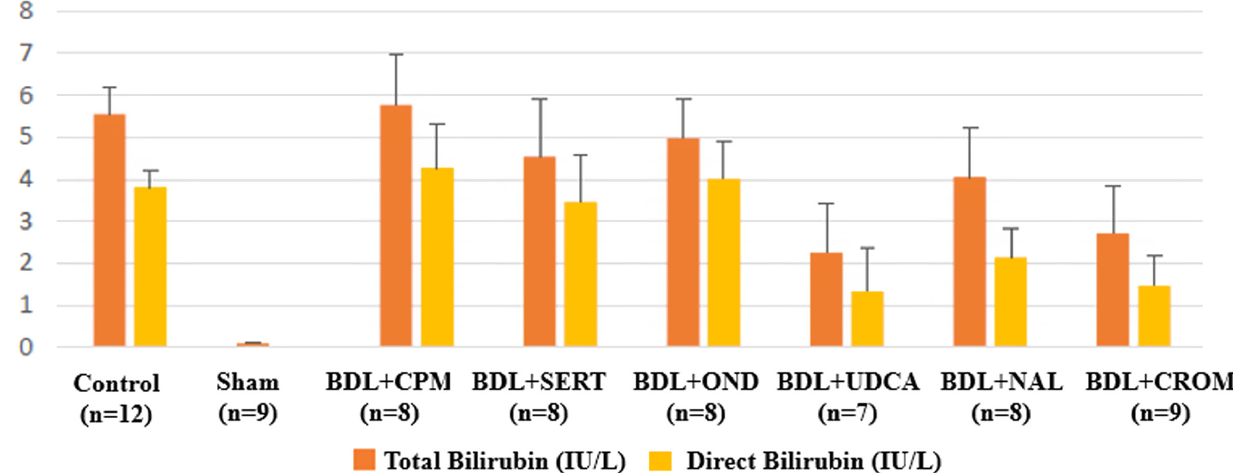
Figure 4. The total and direct bilirubin levels of all the groups are